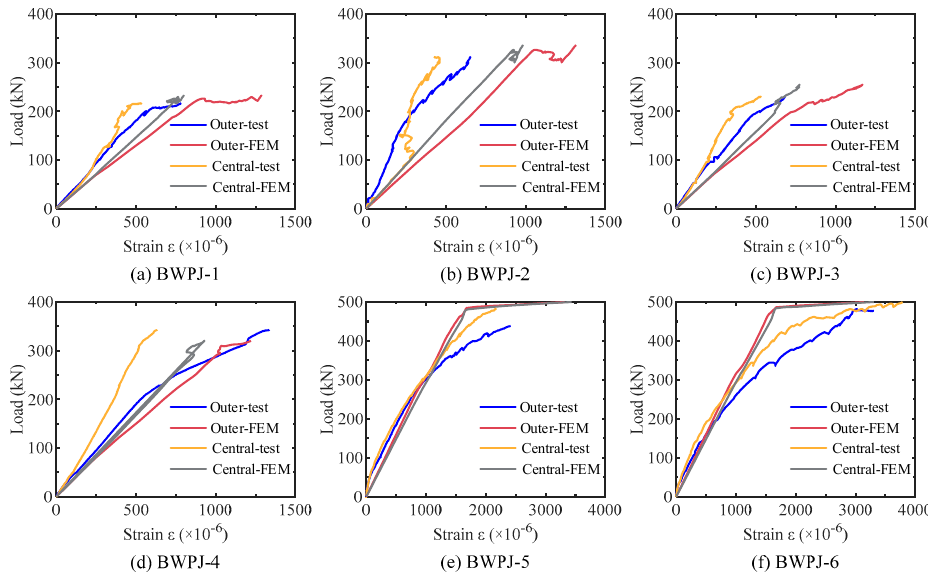
Figure 10. Strain development curves of the web plate of the T ‐ stub connector.